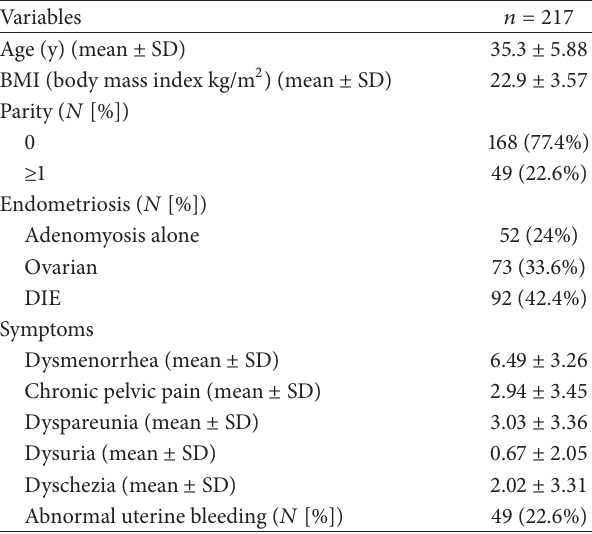
Table 1: Demographic and clinical characteristics of all women